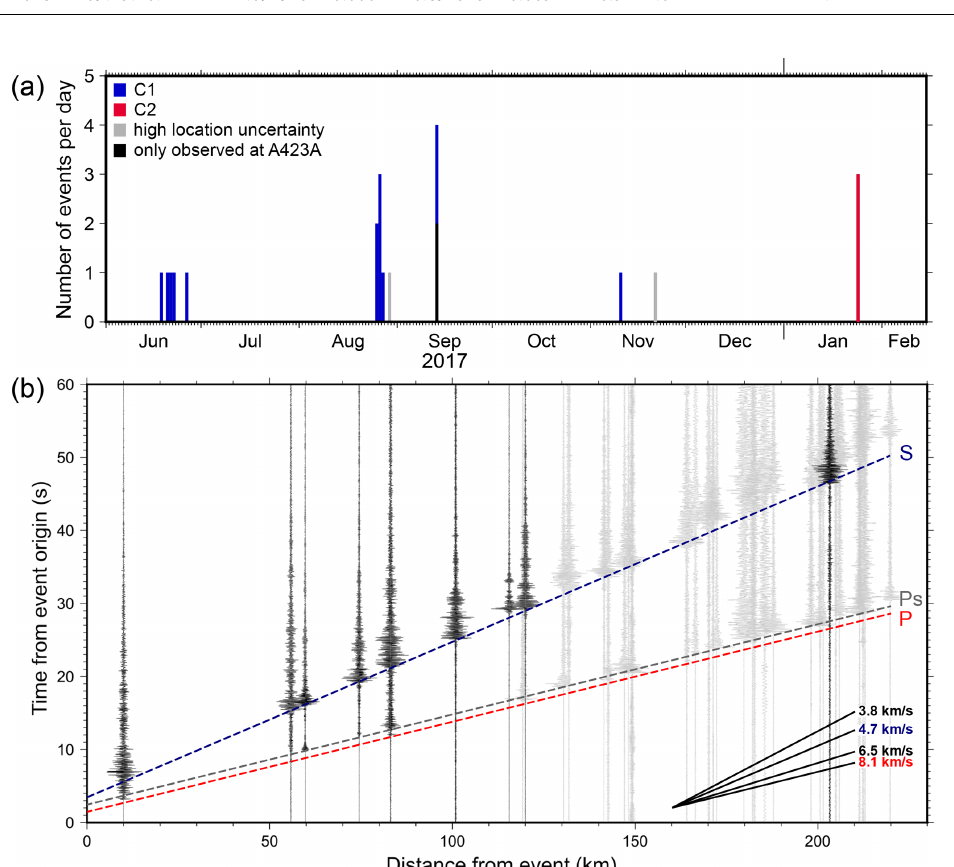
Figure 3. Panel (a) shows the temporal development of the cluster events in blue for C1 and in red for C2. Black events were only observed at A423A and not further analysed. Grey events were located with high uncertainties. (b) Waveforms of the strongest event of C1 (20 June 2017) displayed over offset. Black traces were used for EQ location. A weak P onset (red line) is observed, followed by a stronger Ps phase (grey line) ∼ 1s later. The S phase (blue line) is clearly visible at all stations. Apparent velocities of Vp = 8.1kms − 1 and Vs = 4.7kms − 1 are observed for the phase onsets (marked with dashed lines). More examples in Appendices (Fig. A1).